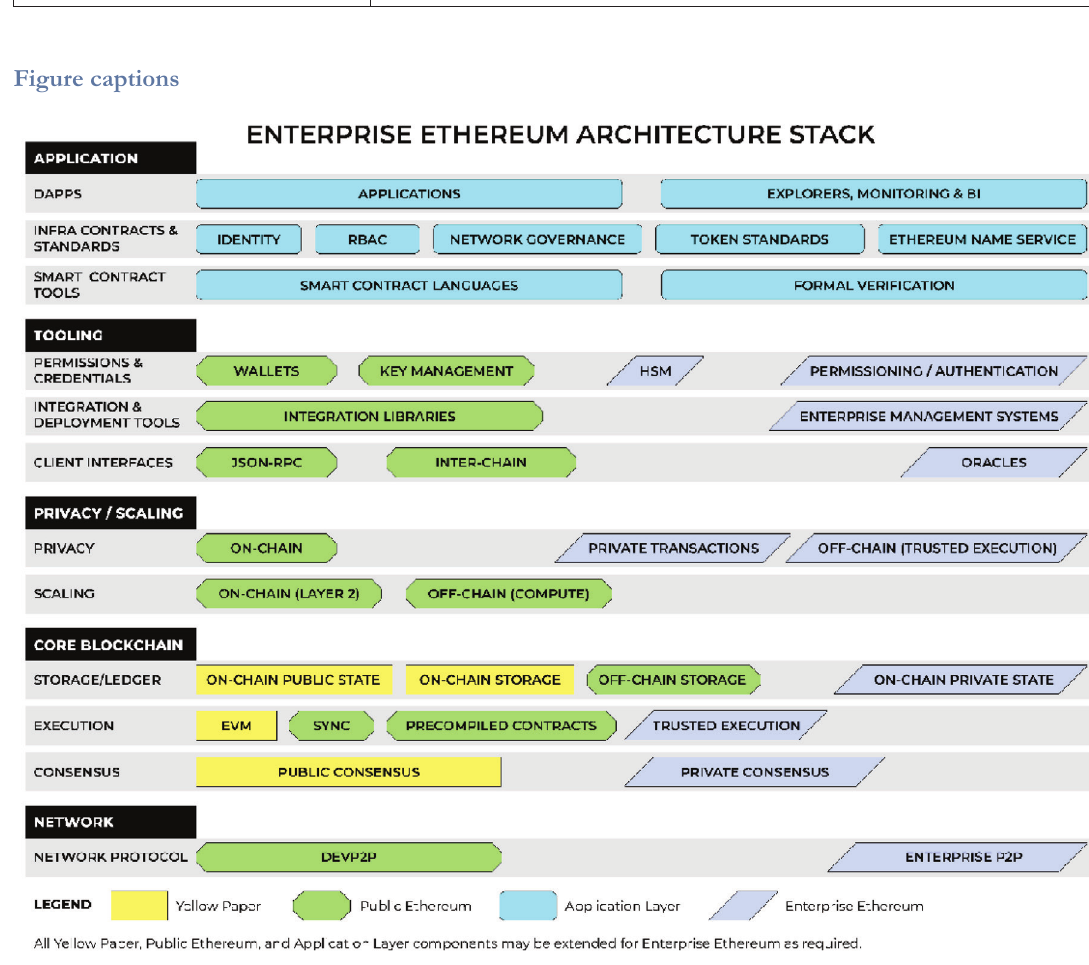
Figure 1. Enterprise Ethereum Stack